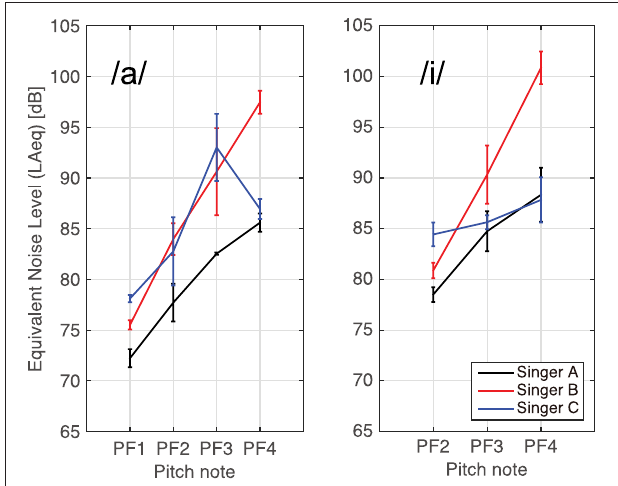
FIGURE 4 | Equivalent noise levels of singing voices for vowels (left) /a/ and (right) /i/. Error bars represent standard deviations.